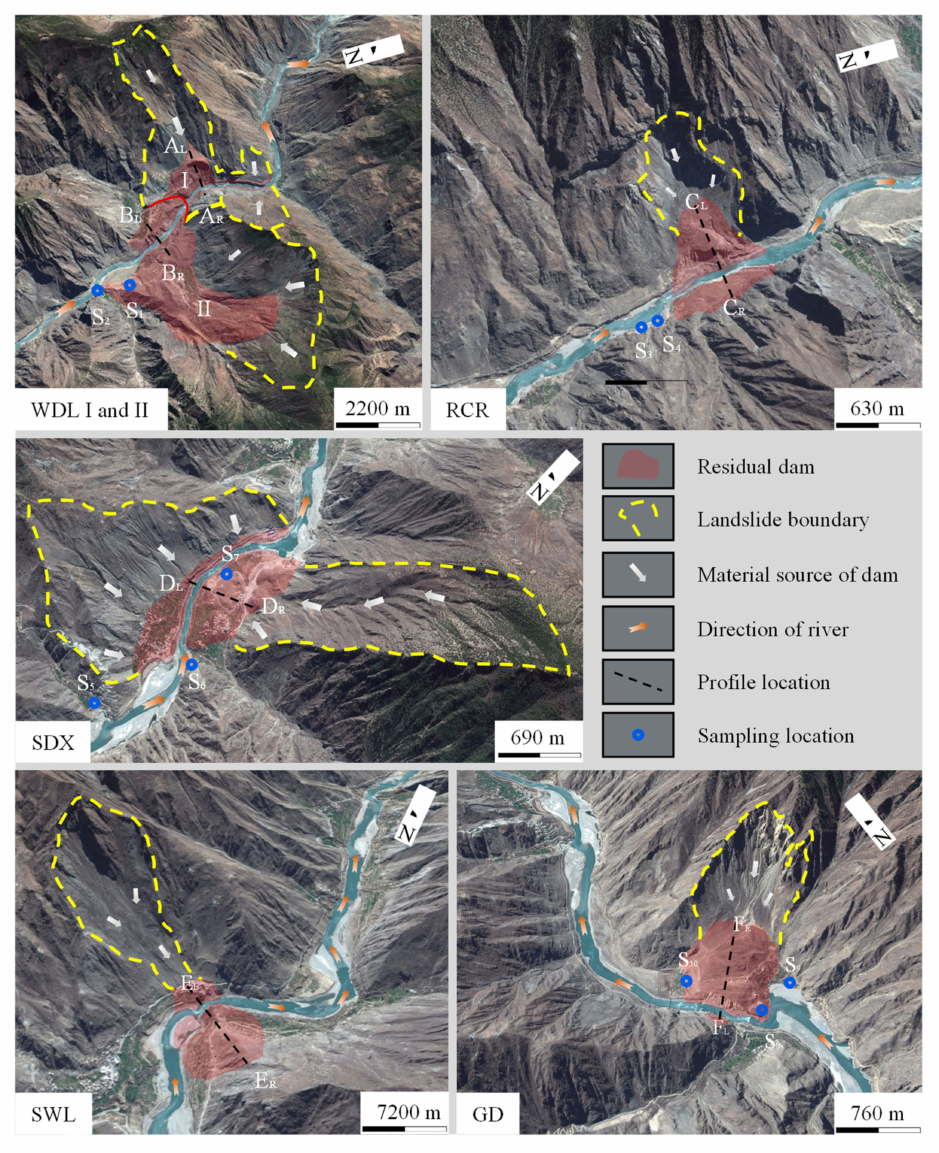
Figure 3. Remote sensing map of river blocking event. (Note: these images are from Google